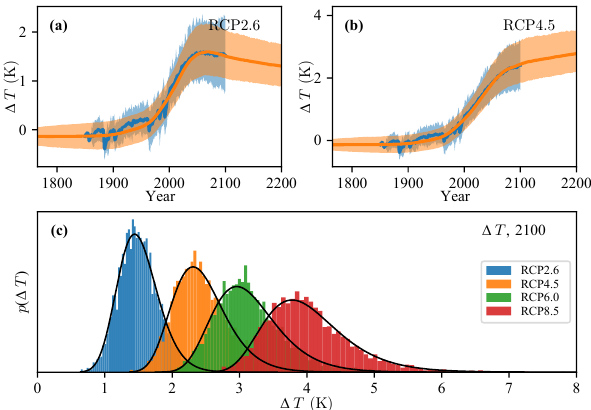
Figure 3. Stochastic state-space model applied to RCP scenarios. (a, b) Ensemble mean and 5th and 95th percentile envelopes of CMIP5 RCPs (blue) and stochastic model (orange). (c) Probability density functions for (cid:49)T in 2100 based on 5000 ensemble mem- bers, and driven by forcing from RCP2.6 (blue), RCP4.5 (orange), RCP6.0 (green) and RCP8.5 (red). In black are fitted log-normal